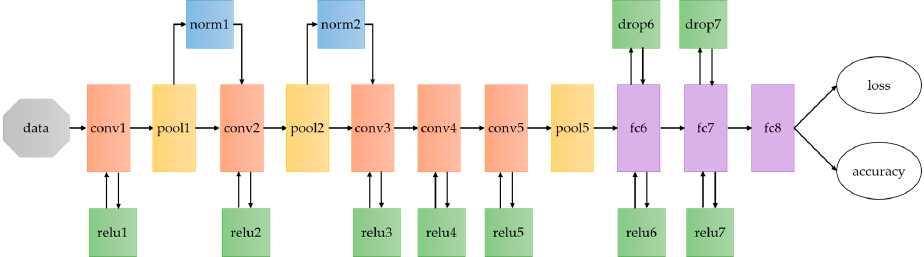
Figure 6. Architecture of CaffeNet. CaffeNet is a deep convolutional neural network modified from AlexNet with two differences: (1) training without the relighting data-augmentation; (2) pooling is switched to be done in front of normalization. CaffeNet is the base network for the proposed indoor scene model training.